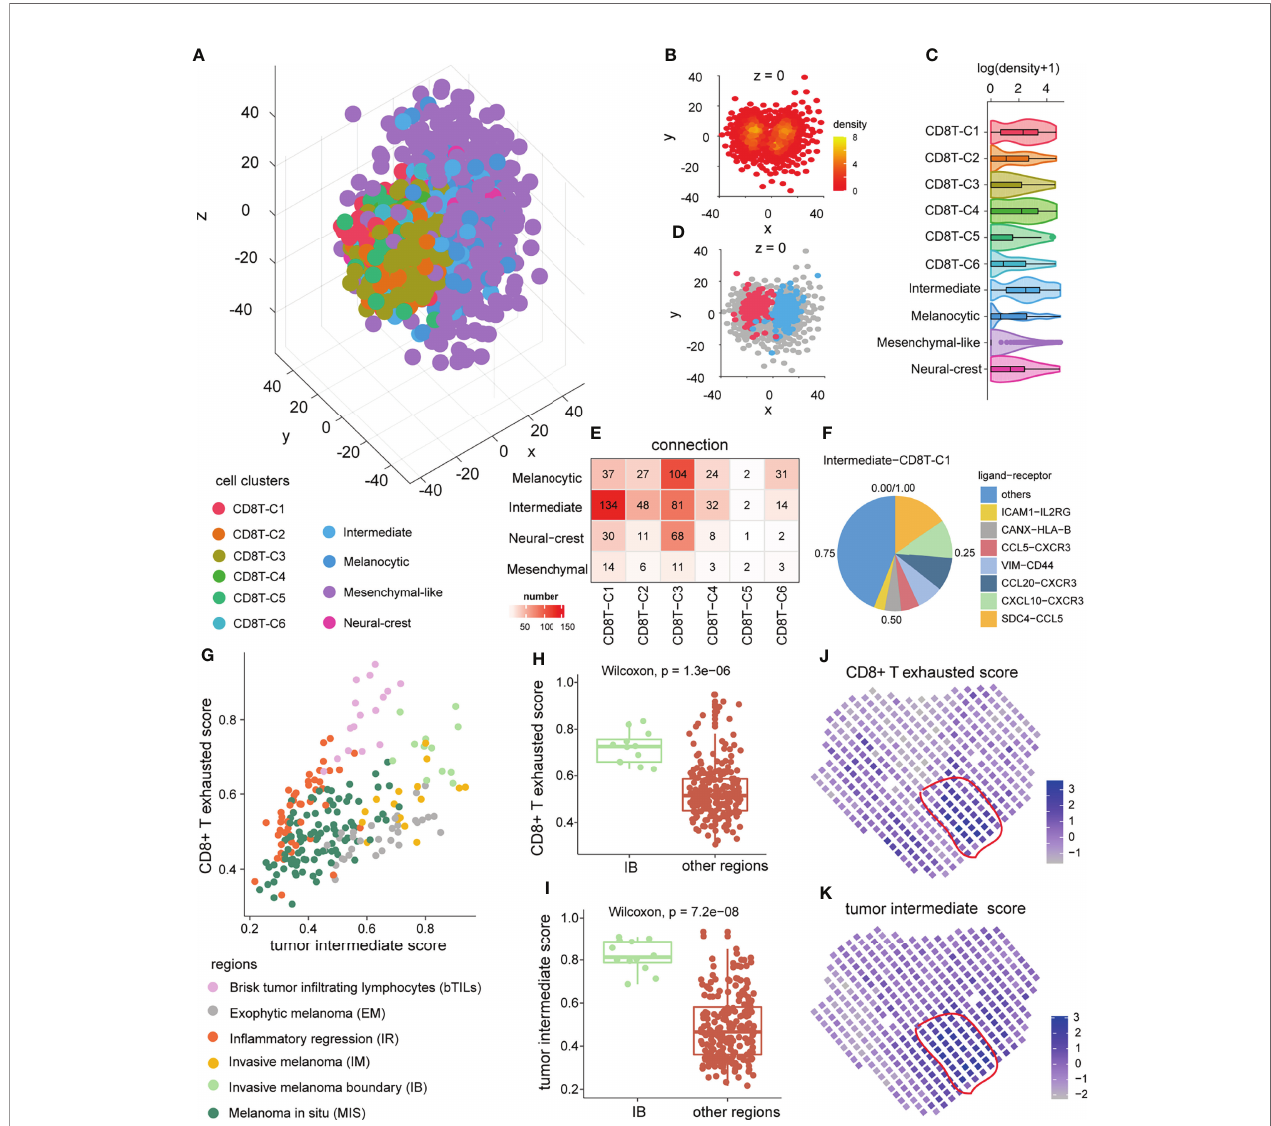
FIGURE 5 | Pseudo-space proximity and spatial co-location between the tumor intermediate state and the CD8+ T exhausted state. (A) Spatial organization of tumor cells and CD8+ T cells in the pseudo-space inferred by CSOmap based on the scRNA-seq data. Each dot represents a cell, and its color represents the corresponding cell state. (B) The cross-section of z = 0 of the pseudo-space. The color of the dots represents cell density. (C) The difference in cell density between 10 cell clusters of CD8+ T cells and tumor cells. (D) Location of intermediate tumor cells (blue) and CD8+ T exhausted cells (red) in the cross-section of pseudo-space z = 0. (E) Numbers of cell – cell connections between tumor cell states and CD8+ T-cell states. (F) The top ligand – receptor interactions and their contribution to pseudo-space proximity of the tumor intermediate state and the CD8+ T exhausted state. (G) The distribution of ssGSEA score of the tumor intermediate state and the CD8+ T exhausted state in distinct annotated microregions from melanoma tumor MEL1-1 (GSE171888). (H, I) The difference in tumor intermediate state ssGSEA score (H) and CD8+ T exhausted state ssGSEA score (I) of micro-regions between invasive melanoma boundary region and other regions in the melanoma tumor MEL1-1. (J, K) The CD8+ T exhausted state ssGSEA score (J) , and tumor intermediate state ssGSEA score (K) of spatial spots in another melanoma sample